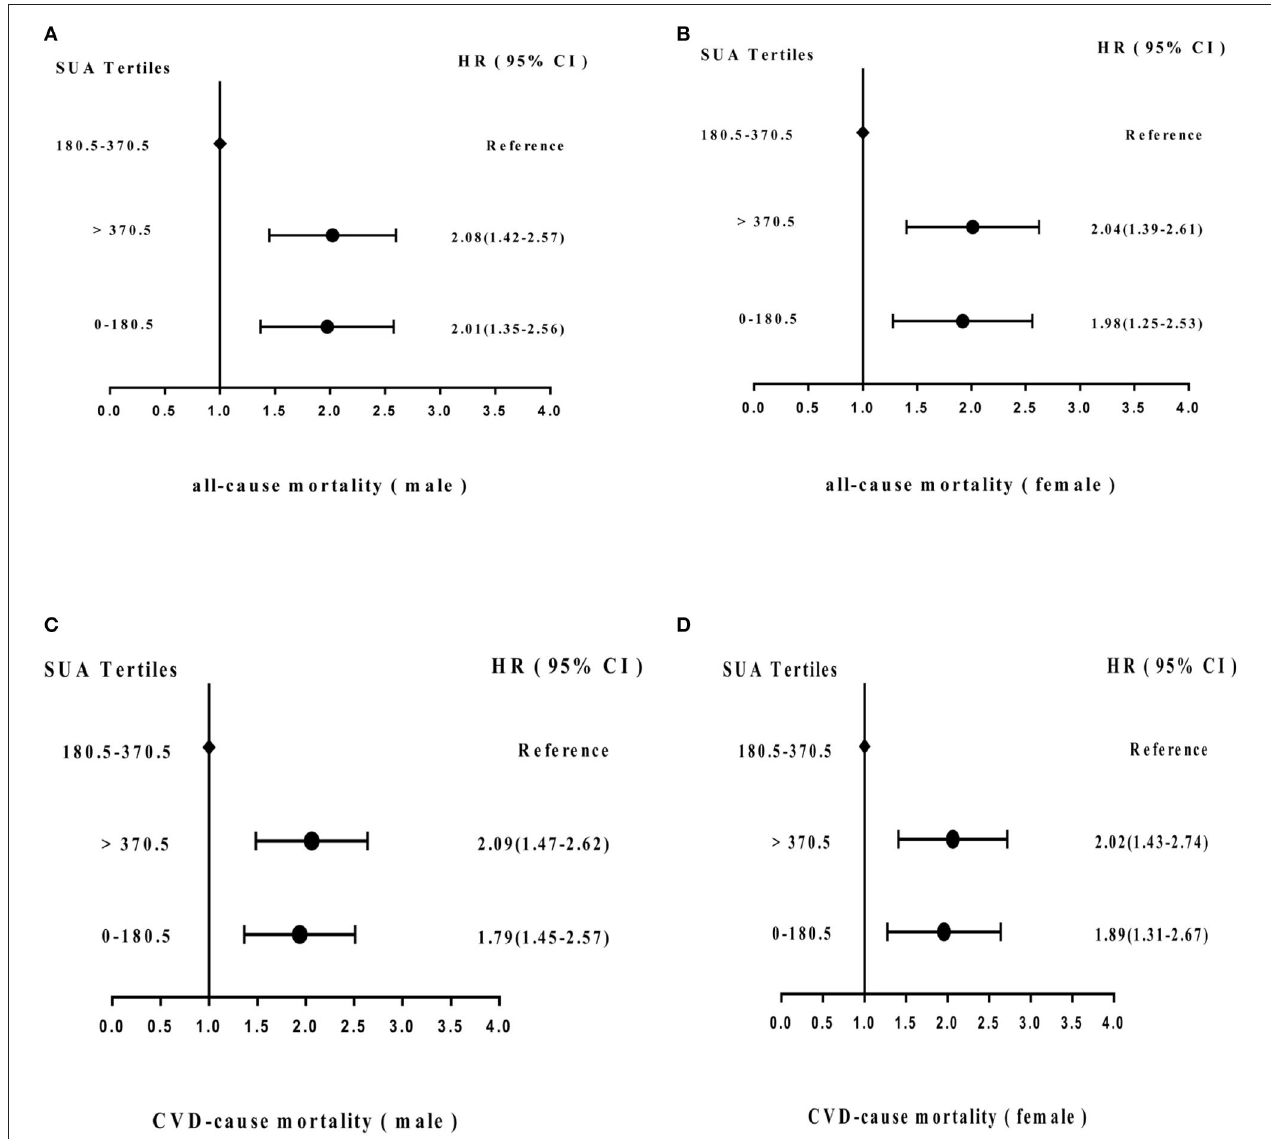
FIGURE 5 | Adjusted hazard ratios (HRs) for (A) all-cause mortality (male) and (B) (female) and (C) cardiovascular disease (CVD) mortality (male) and (D) (female) according to cutoff values of SUA level in the cohort study during 6-year follow-up. CI, confidence